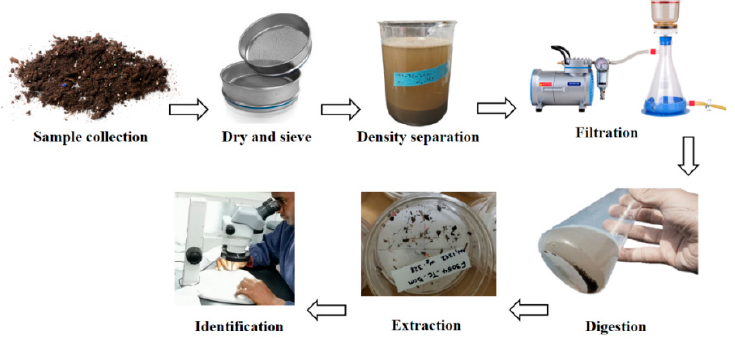
Figure 2. Schematic diagram in analytical procedures for MPs extraction in soil samples.